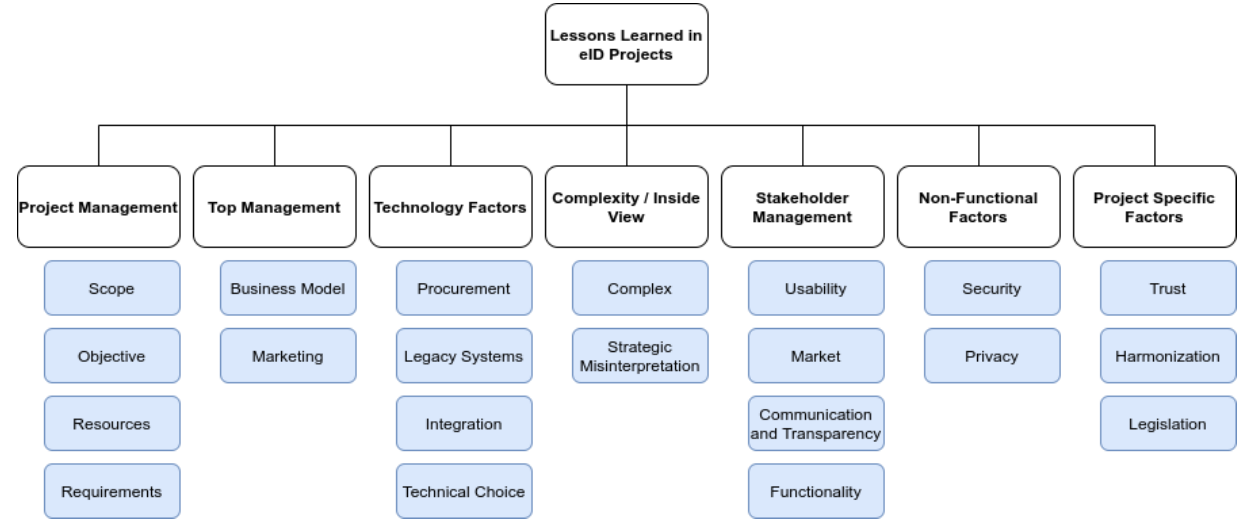
Figure 4. Taxonomy based on challenges in eID